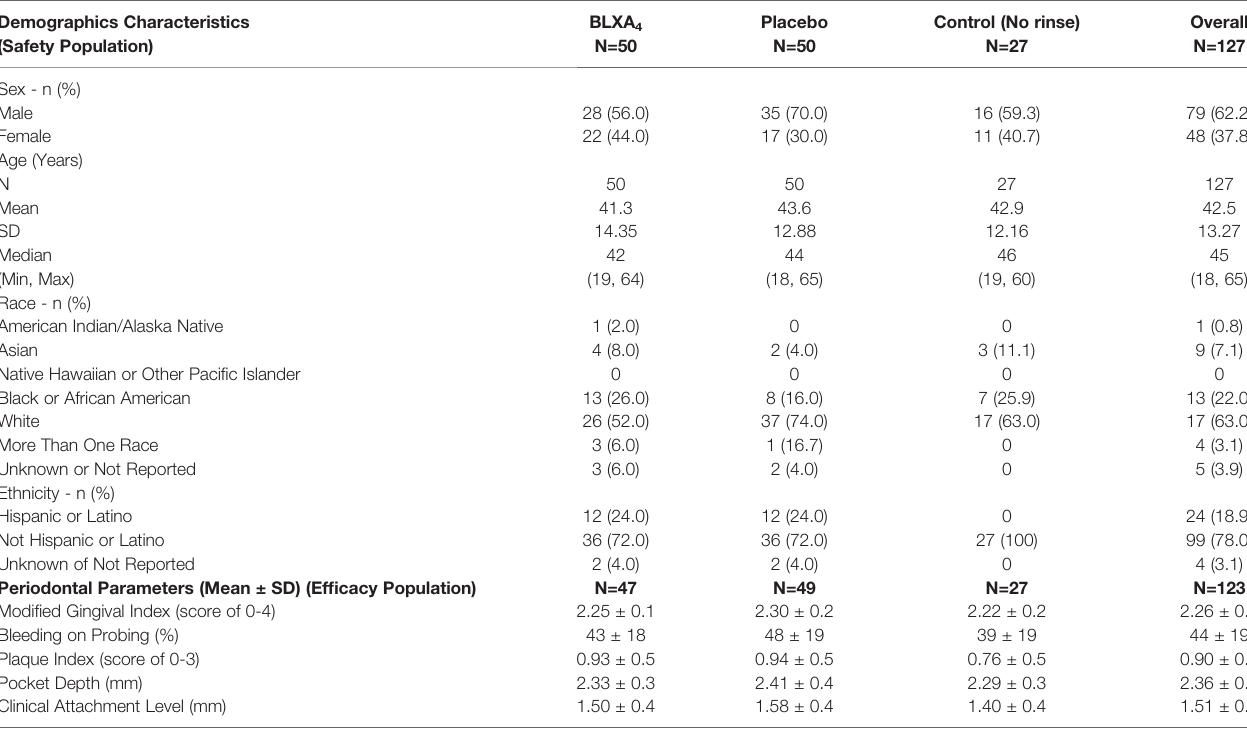
TABLE 2 | Baseline clinical parameters (with 95% CI) and participant demographics by study group (safety and ef fi cacy populations). Demographics Characteristics